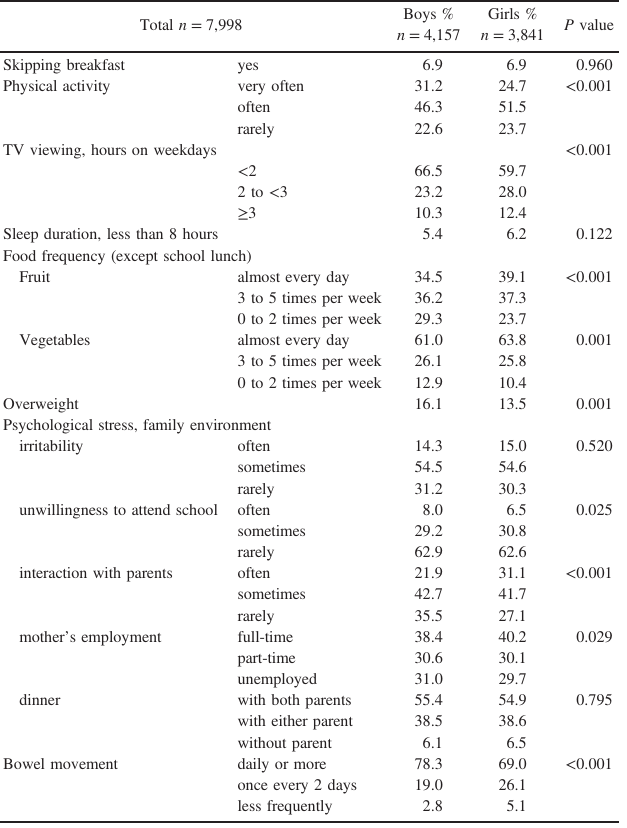
Table 1. Characteristics of participants by sex Total n =